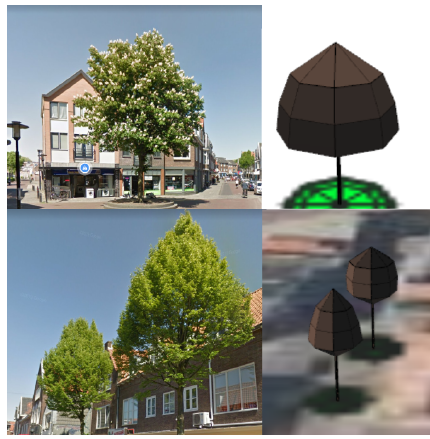
Figure 8. Result City Center